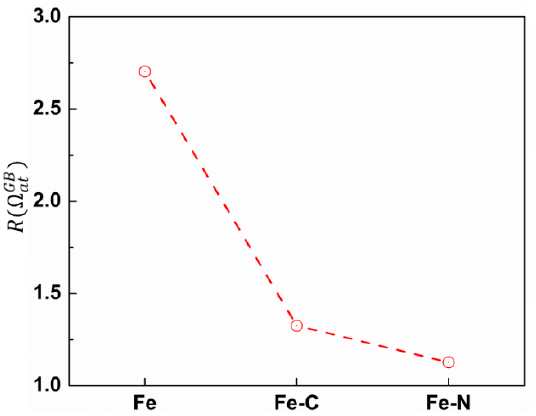
Ω > Ω and the number of > Ω Fe and the number of at at at ,0